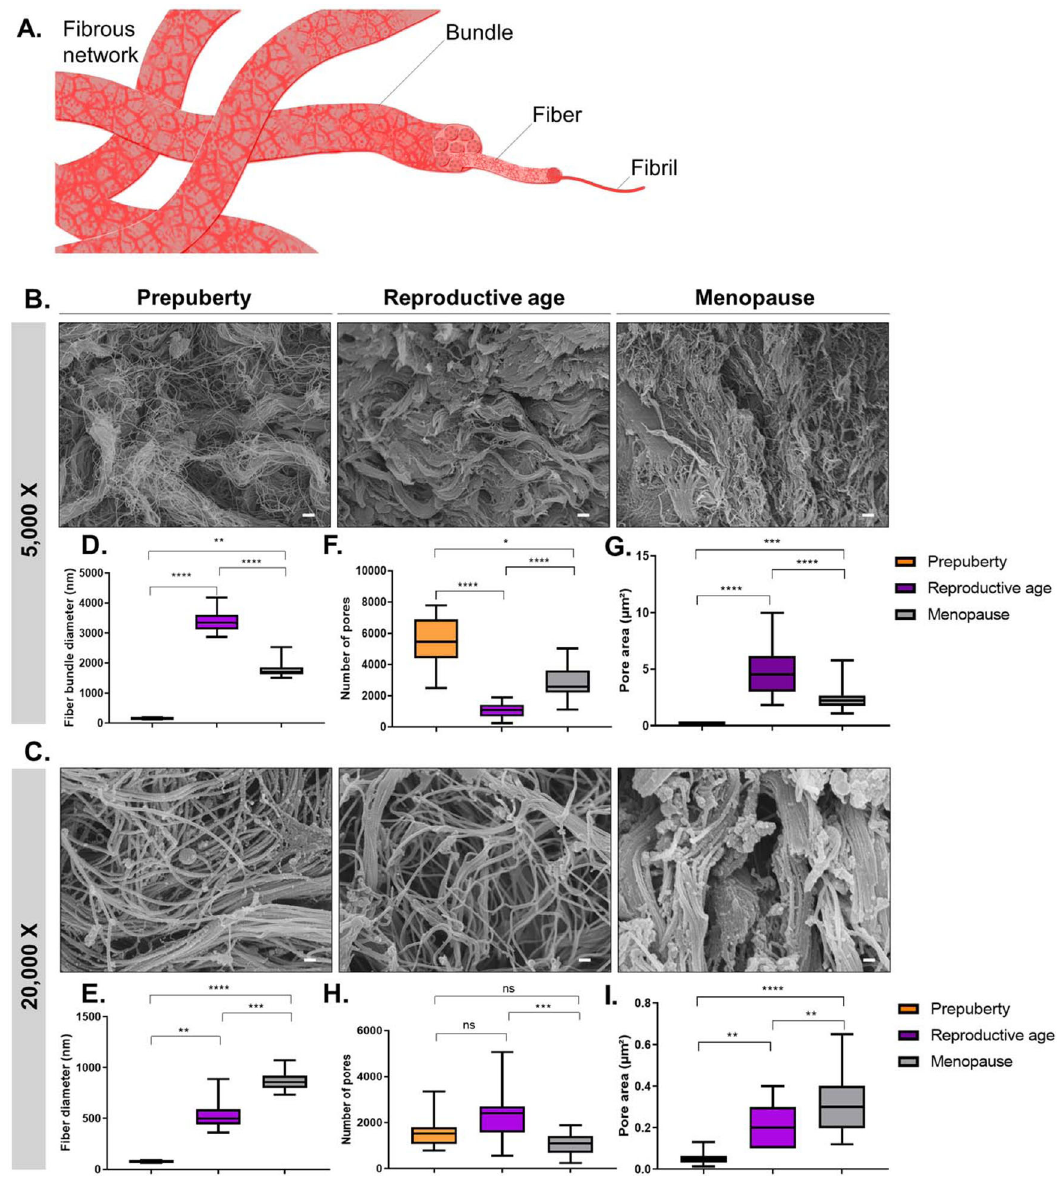
Fig. 1 ECM microstructure and fi brous network morphology in human ovarian tissue from prepuberty to menopause. A Schematic illustration of the fi brous network anatomy composed of fi brils, fi bers, and fi ber bundles, as de fi ned in this study. SEM micrographs revealed: B the ECM network structure at fi ber bundle scale (×5000 magni fi cation) and C fi ber scale (×20,000 magni fi cation). D , E At prepuberty (number of biological replicates [ n ] = 5), ovarian tissue is composed of the thinnest fi bers (mean ± SD: 76.1 nm ± 9.8) assembled into the thinnest bundles (160.0 nm ± 21.3), densifying upon puberty ( fi ber scale: 528.4 nm ± 128.0; fi ber bundle scale: 3379.0 nm ± 368.8). F – I Fiber and bundle spacing deduced from pore number and area revealed a tight ECM network at prepuberty, illustrated here by large numbers of pores (5430 ± 1688) occupying the smallest area (0.19 µ m 2 ± 0.05). At reproductive age ( n = 5), human ovarian tissue is characterized by fi bers of intermediate diameter (528.4 nm ± 12.8) assembled into the thickest bundles compared to prepubertal ( n = 5) and menopausal ( n = 5) tissues, forming a looser fi brous network with greater pore spaces (4.9 µ m 2 ± 2.4). While at high magni fi cation, we found menopausal tissue to be composed of smaller pore numbers occupying greater areas than at reproductive age (1054 ± 470); a similar observation at lower magni fi cation revealed tighter network organization at menopause (0.32 µ m 2 ± 0.15). These pore-spacing differences between age groups may play a role in permeability change with age. Boxplots display 25th and 75th percentile, median (line), and the whiskers extending to the last data point not considered outlier. Fiber and pore analyses were conducted using DiameterJ. One-way ANOVA (post hoc: Tukey) was used to compare pore area. Differences in fi ber morphology and pore number were analyzed by Kruskal – Wallis test (post hoc: Dunn) (* p < 0.05; ** p < 0.01; *** p < 0.001; **** p < 0.0001). Scale: 1 µ